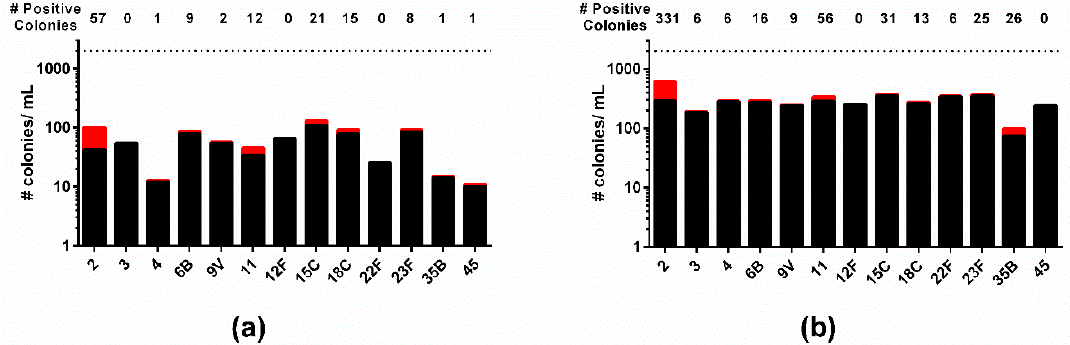
Figure 3. Identification of clones with high efficiency of allelic replacement streamlined multitude of capsule swaps. ( a ) TIGR4S ∆ cps::NewSweetJanus and ( b ) D39S ∆ cps::NewSweetJanus were transformed with genomic DNA from strains of different serotypes (below column). The number of true-positive colonies (red bars, number above column) and the number of false-positive colonies (black bars) were determined per mL of transformation. Dashed line represents upper limit of detection.